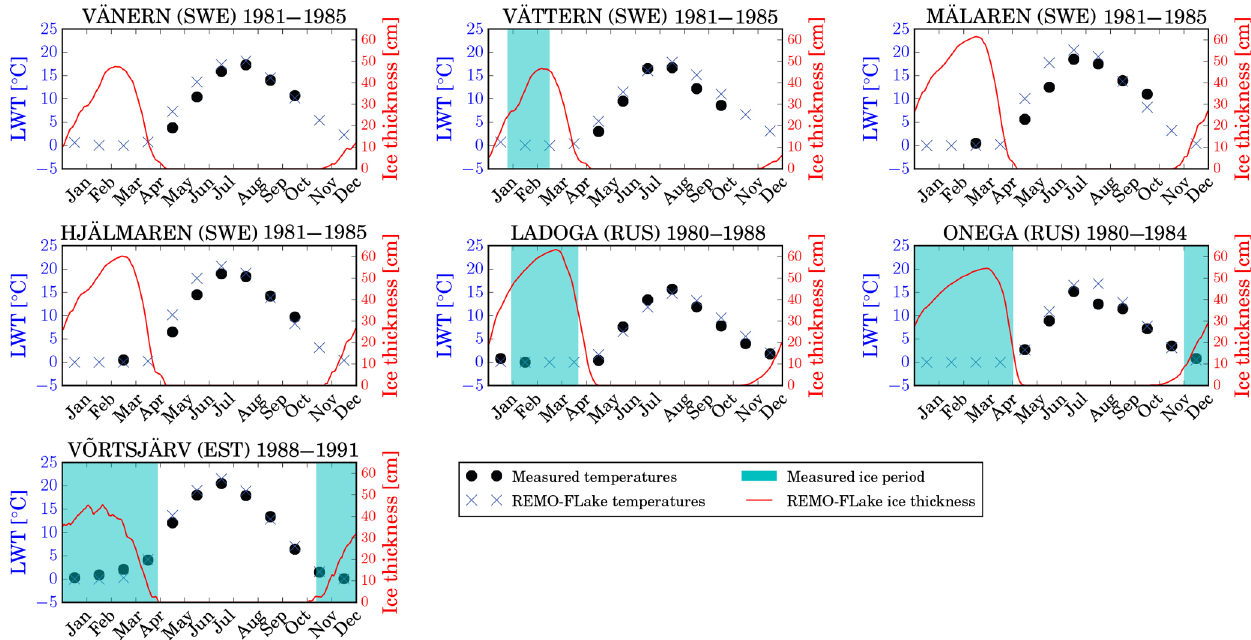
Figure 7. Measured and modeled lake water temperatures (LWTs) and ice periods from Sweden, Russia and Estonia. The lake temperatures for Lake Ladoga are calculated only for the northern part (following the measurement approach), but the ice period and depth are for the whole